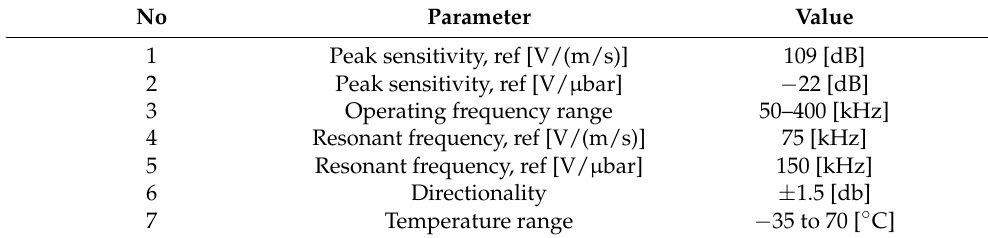
Table 1. Operating specification of R151-AST.